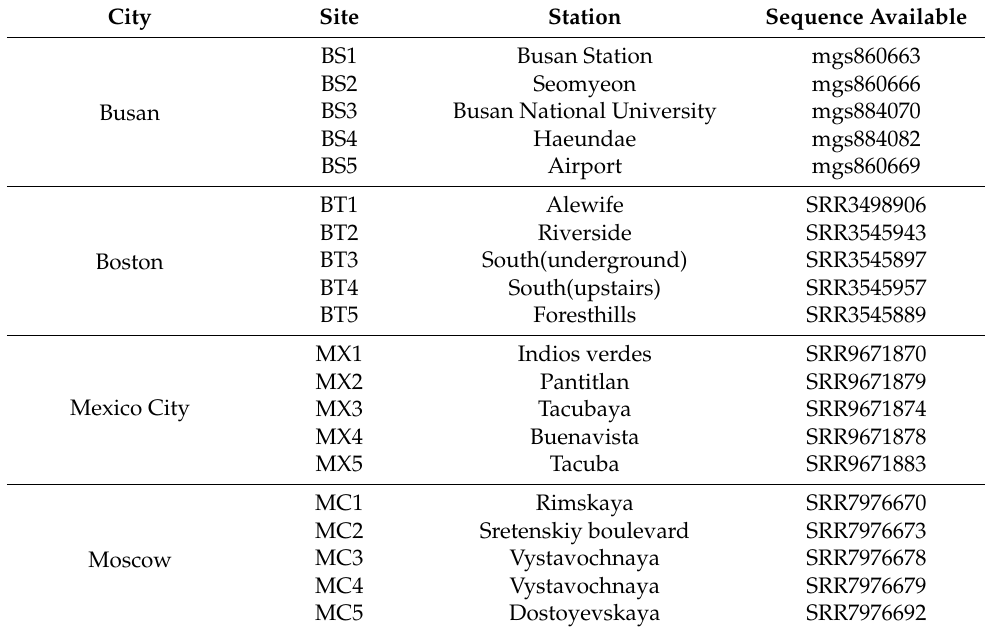
Table 1. Samples and obtained sequences information in this